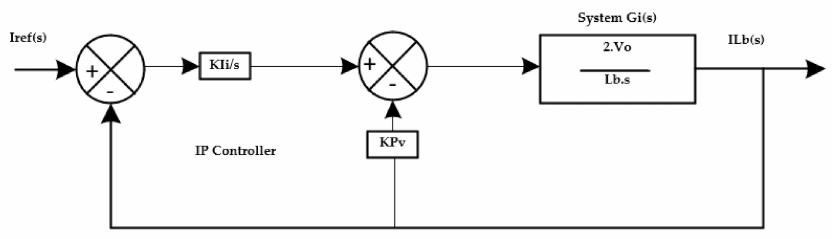
Figure 15. Block diagram of the inner current control system with the proposed IP